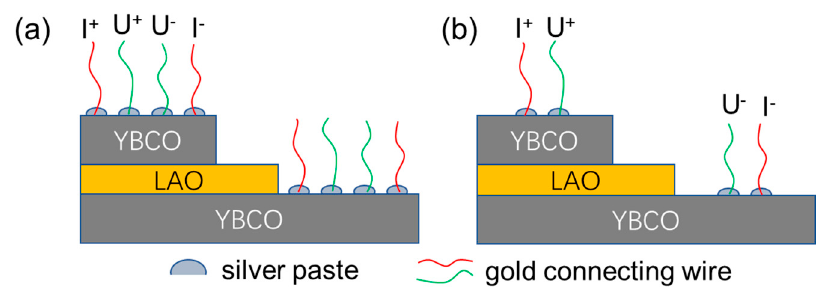
Figure 1. Diagrammatic drawing for measuring T c of top and bottom YBa 2 Cu 3 O 7 − x (YBCO) layer ( a ) and I – V characteristics of the trilayer films ( b ).